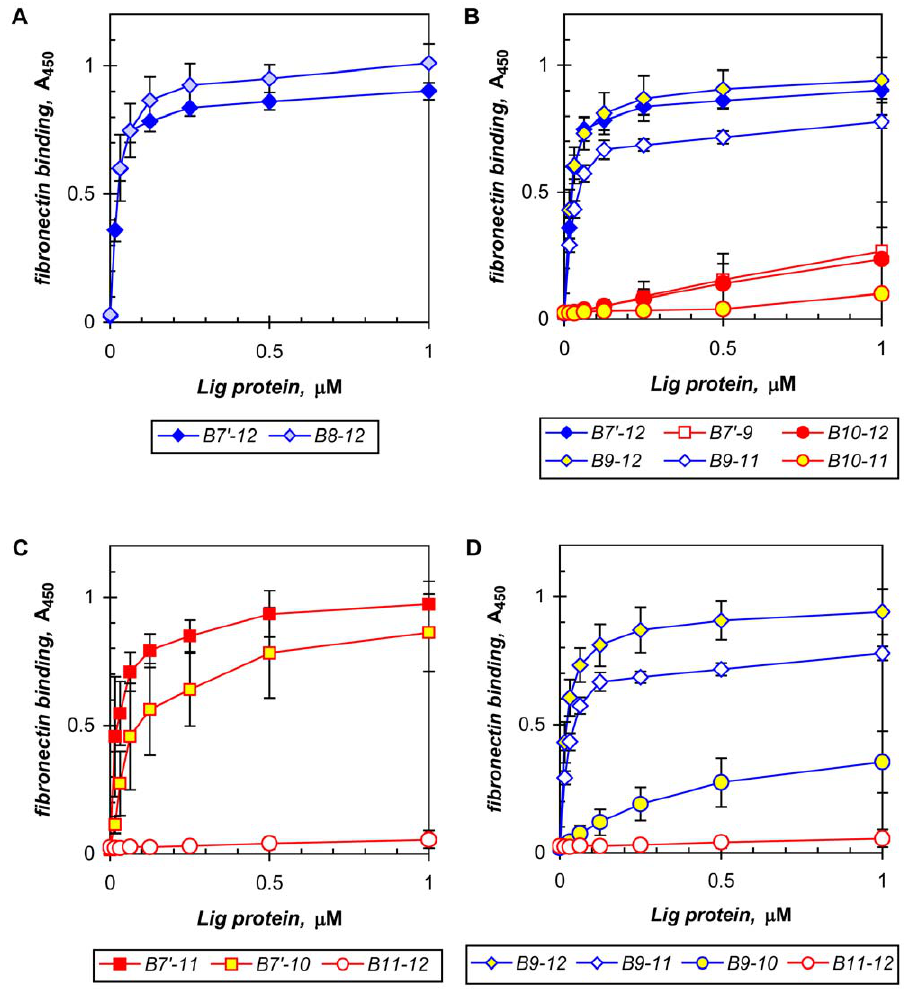
Figure 4. LigB repeats in fibronectin binding. Recombinant LigB proteins comprising the indicated immunoglobulin-like repeats were tested in an ELISA to identify the fibronectin-binding region. Composite binding curves with means and standard deviations (standard errors for LigB7 9 -12 and LigB9-11) from multiple assays depict their comparative binding avidities to demonstrate that A ) repeat 7 is not necessary, B ) repeat 9 is necessary along with a nexus with repeat 10, and C , D ) repeats 11 and 12 do not bind directly, but are involved in the interaction with fibronectin. See text and Table 2 for the apparent K d s.